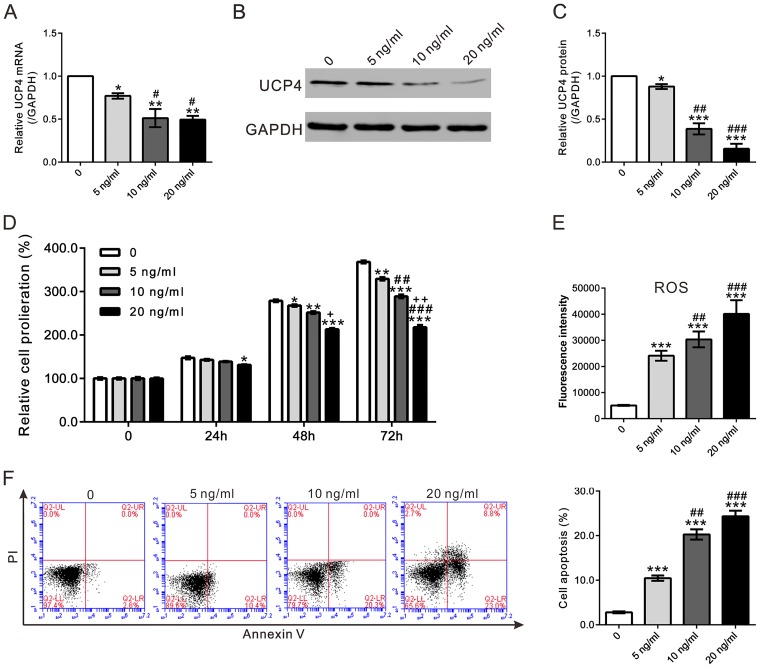
Leptin modulated UCP4 expression, cell proliferation and cell apoptosis.(A, B, C) Rat chondrocytes were treated with recombinant leptin (0–20 ng/ml) for 48 h. Then, the mRNA and protein level of UCP4 of chondrocyte cultures was detected. (D) Rat chondrocytes were treated with recombinant leptin (0–20 ng/ml) and cell proliferation was detected. Results of cell growth were normalized to the initial cell numbers (100%). (E, F) Rat chondrocytes were treated with recombinant leptin (0–20 ng/ml) for 48 h, and ROS and cell apoptosis was analyzed. *P <0.05, **P<0.01 and ***P <0.001 versus non-treated cells (0). #P <0.05, ##P<0.01 and ###P <0.001 versus 5 ng/ml leptin-treated cells. +P <0.05 and ++ P<0.01versus 10 ng/ml leptin-treated cells.